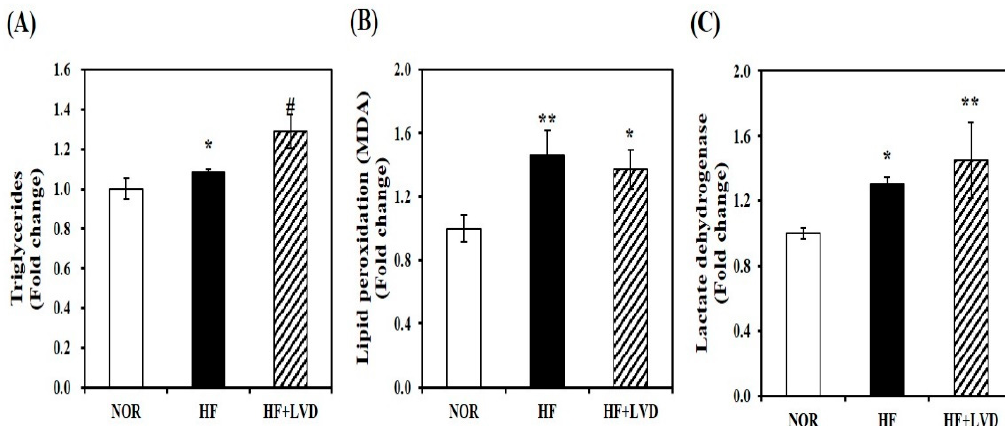
Figure 2. Influence of vitamin D insufficiency on muscle fat deposition, lipid peroxidation, and tissue damage. Muscle triglyceride concentrations ( A ), malondialdehyde (MDA) contents ( B ), and lactate dehydrogenase (LDH) levels ( C ) were normalized to their respective protein concentrations and expressed as the fold change compared to NOR. Data are expressed as mean ± SEM ( n = 7–9). * p < 0.05; ** p < 0.01 compared to NOR. # p < 0.05 compared to HF. NOR, 10% fat diet with 1000 IU vitamin D; HF, 45% fat diet with 1000 IU vitamin D; HF + LVD, 45% fat diet containing 25 IU vitamin D.